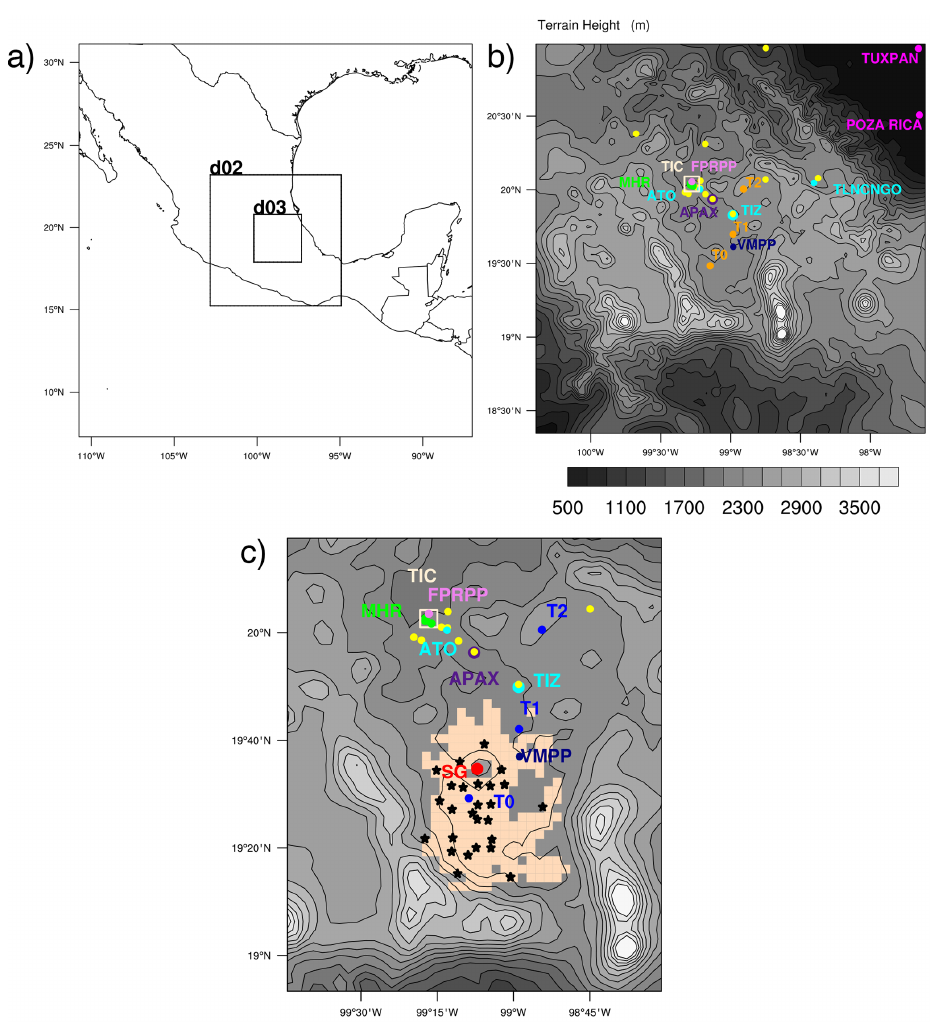
Figure 1. WRF-Chem modeling domains: (a) outer domain encompassing Mexico and nested domains. (d02 and d03); (b) Inner (d03) domain showing the location of MILAGRO supersites (orange), FPRPP (violet), Miguel Hidalgo Refinery (MHR; green), cement plants (yellow), Tizayuca (TIZ), Atotonilco (ATO) and Tulancingo (TLNCNGO) municipalities in state of Hidalgo (cyan), Apaxco (APAX) munic- ipality in State of Mexico (purple) and Valle de Mexico power plant (VMPP) (blue). The square denotes the Tula industrial complex (TIC). In addition, the approximate locations of the Tuxpan power plant and the Poza Rica industrial complex (magenta) are shown in d03. (c) Detail of the extent of the Mexico City Metropolitan Area (light brown) including the location of the monitoring stations (black stars) and the Sierra de Guadalupe (SG) in the inner domain d03. Note that cement plants in Atotonilco, Tizayuca and Apaxco are super-imposed over the respective municipalities, that the color of supersite locations are different in panel (c) , and that names do not necessarily correspond to exact locations for better